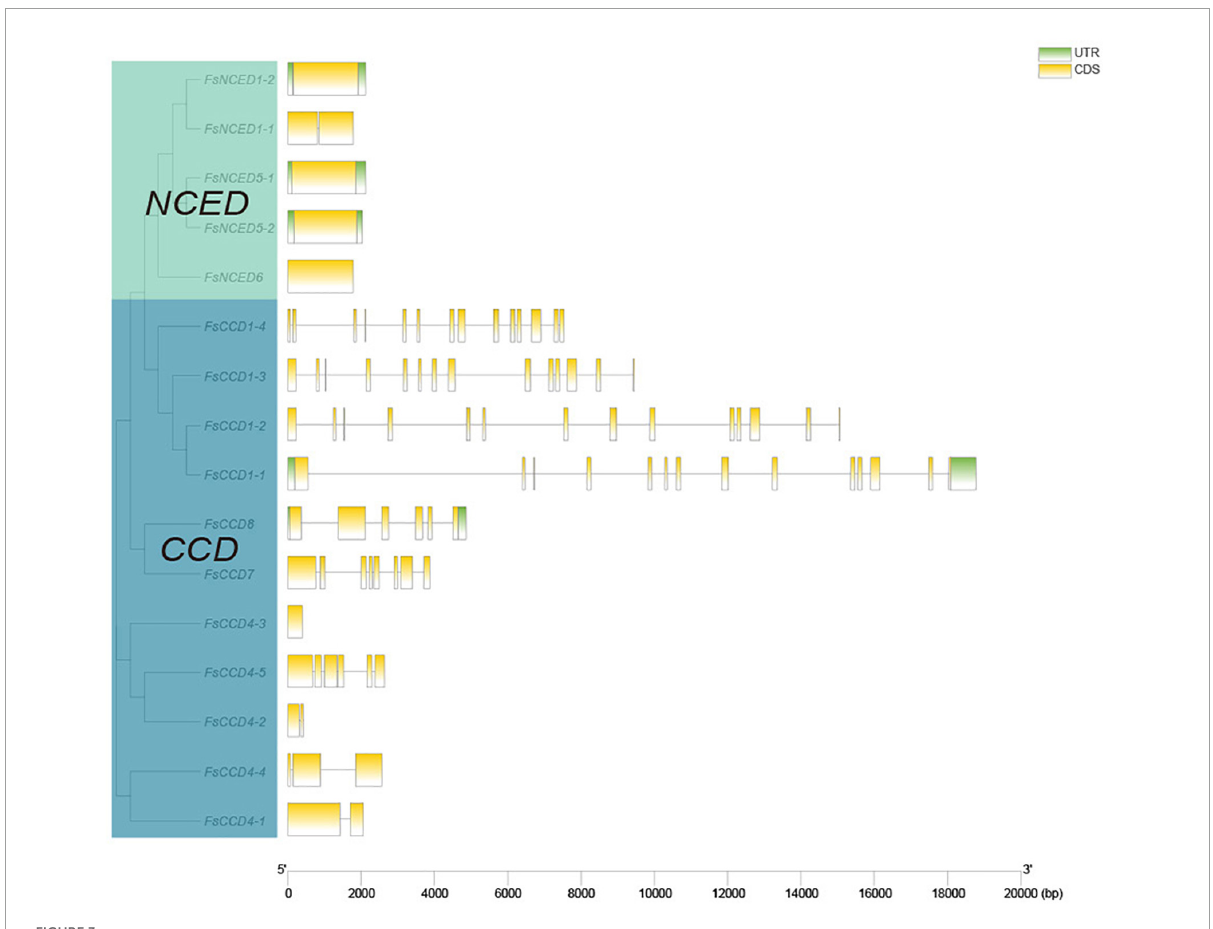
FIGURE3 Gene structure analysis of CCD genes of Forsythia suspensa